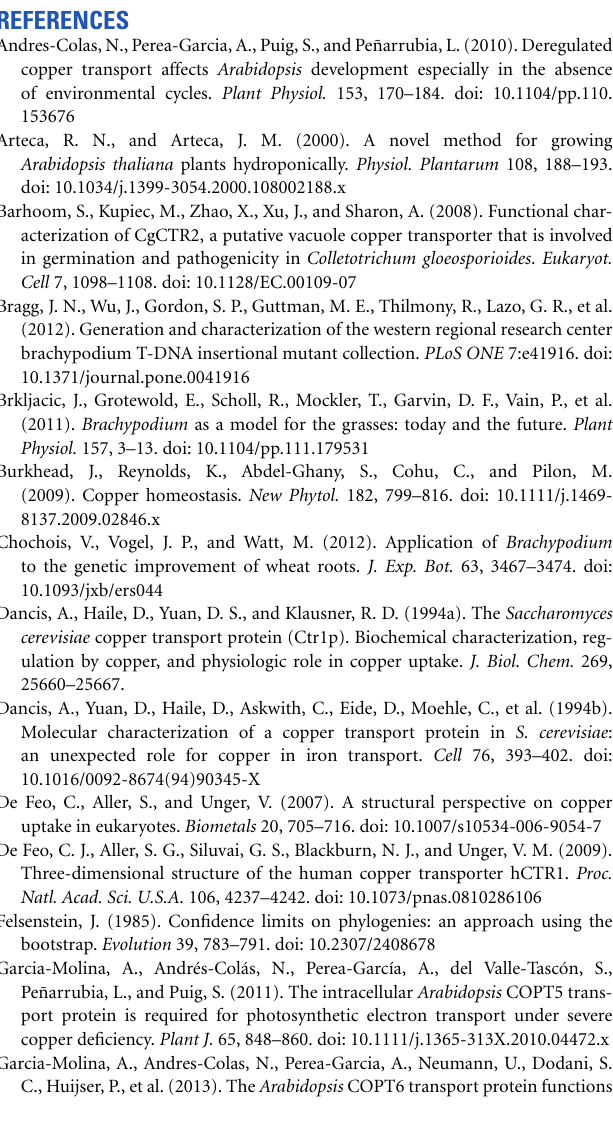
Supplemental Table 2 | Solutions used in protoplast isolation and transfection. All solutions were filter sterilized before